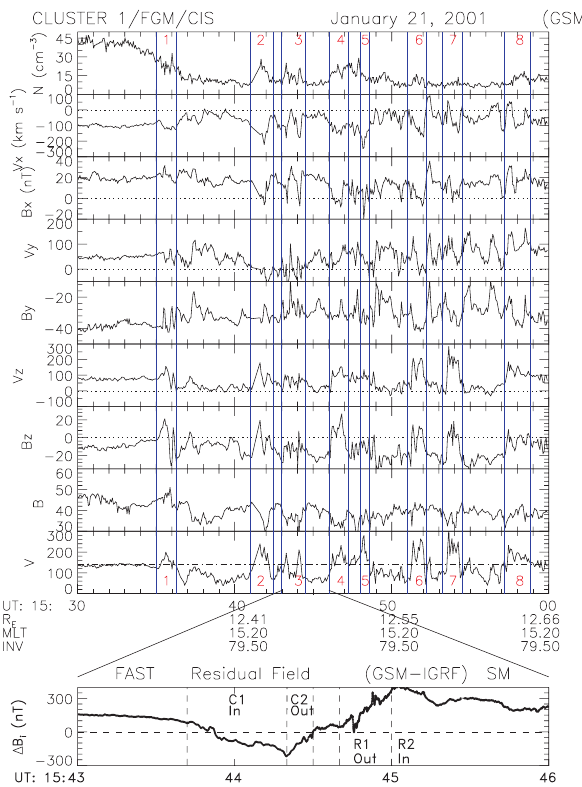
Fig. 11. Top: Expanded view of Cluster data showing density and components and magnitude of ion velocity and magnetic field. Eight flow bursts are marked in the figure. Bottom: Cross-track magnetic field (IGRF model subtracted) observed at FAST. The flow bursts are embedded in the FAC pair labeled C1/C2 in the bot- tom